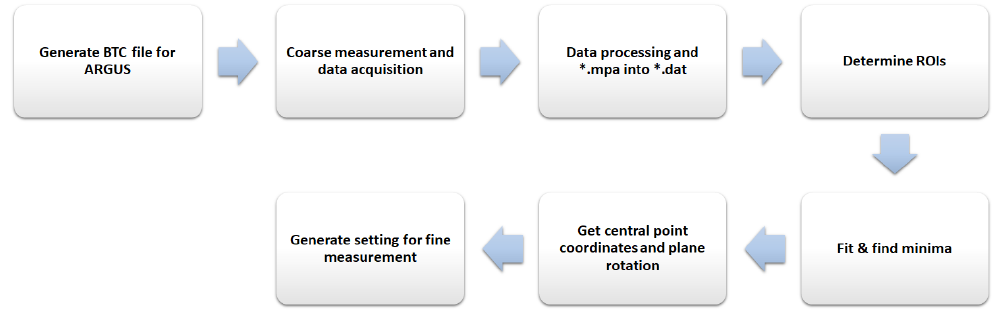
Figure 7. Coarse RBS/C methodology.